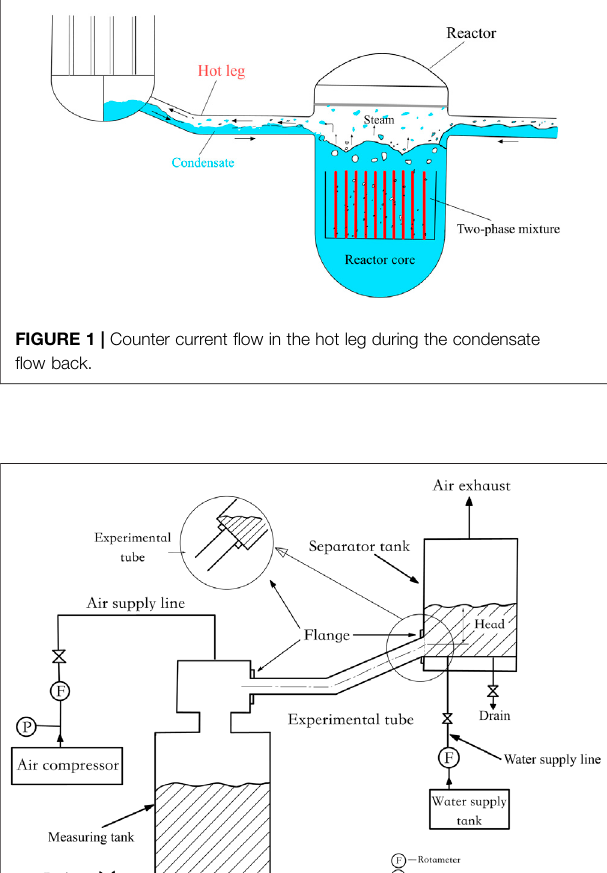
Figure 1 . In recent years, international scholars have carried out